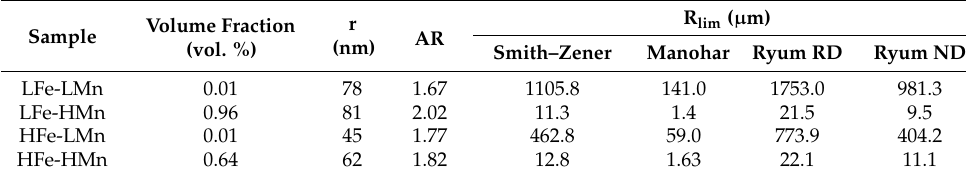
r: average dispersoid radius; AR: aspect ratio of the ellipsoidal particles; R lim : calculated limiting grain radius using different Zener pinning model